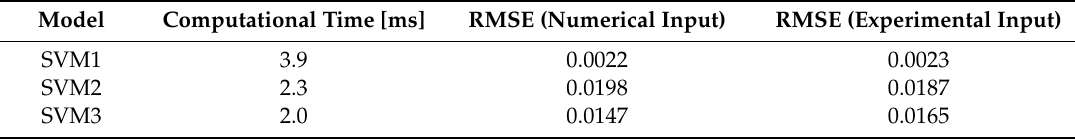
Table 3. Comparison of accuracy and computational time for obtained SVM